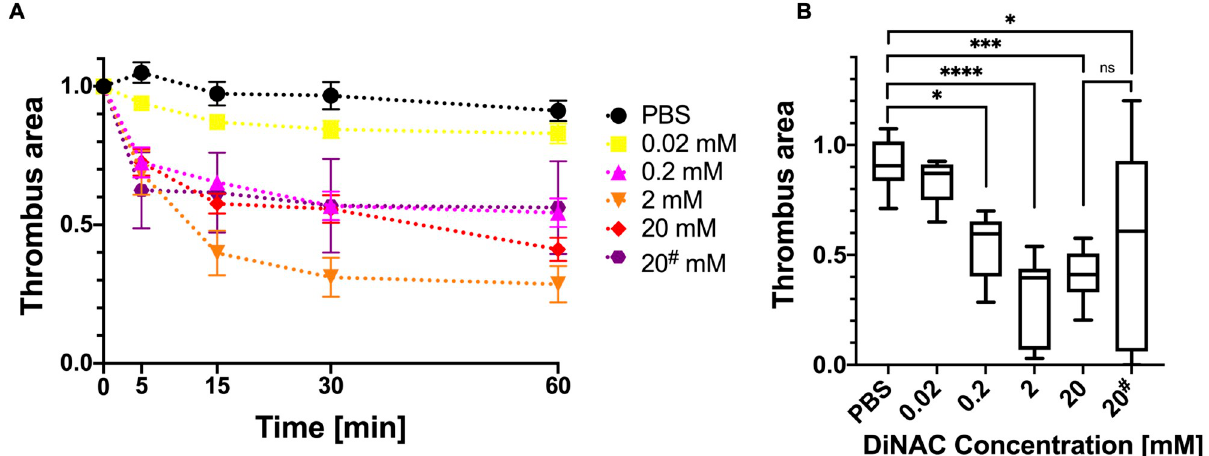
Fig 3. DiNAC dosage response with concentrations of 0.02, 0.2, 2, and 20 mM. The # denotes the acidic DiNAC 20 mM solution. A Thrombus area reduction over time. The control is shown in black. 0.02 mM DiNAC was not different from the control (yellow), and 2 mM DiNAC (orange) had the greatest efficacy B Thrombus area after 60 min perfusion with increasing concentrations of DiNAC. Concentrations of 0.2 mM and greater were significantly different from the control. Neutralization of DiNAC mitigated variability and increased the surface area reduction (20 vs. 20 � mM). � p < 0.05; ��� p < 0.001; ���� p <